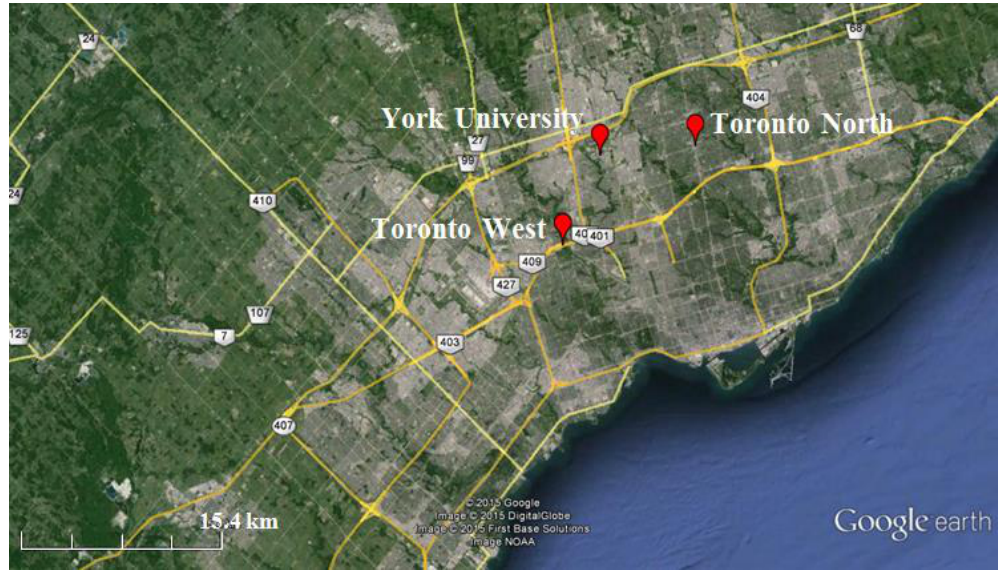
Figure 2. Map showing the sampling site (York University) as well as the Ontario Ministry of Environment (OME) sites (Toronto West and Toronto North) that collected pollutant data. The map was produced using Google Earth Pro, 2015 © Google, 2015 © DigitalGlobe, 2015 First © Base Solutions and NOAA (August, 2009). Table 2. Summary of ambient isotope ratio measurements of nitrophenols.